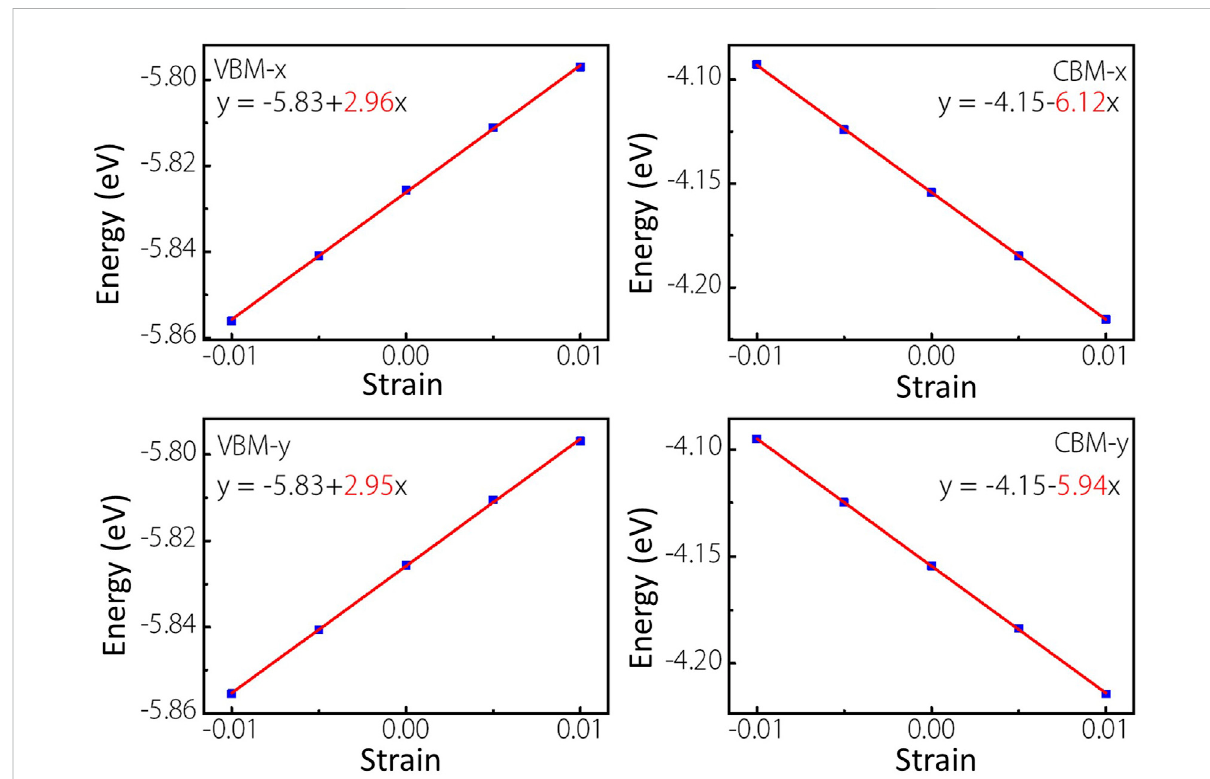
FIGURE 7 Linear fi tting maps of VBM and CBM locations of MoWS 4 monolayer under the strain along x and y directions.